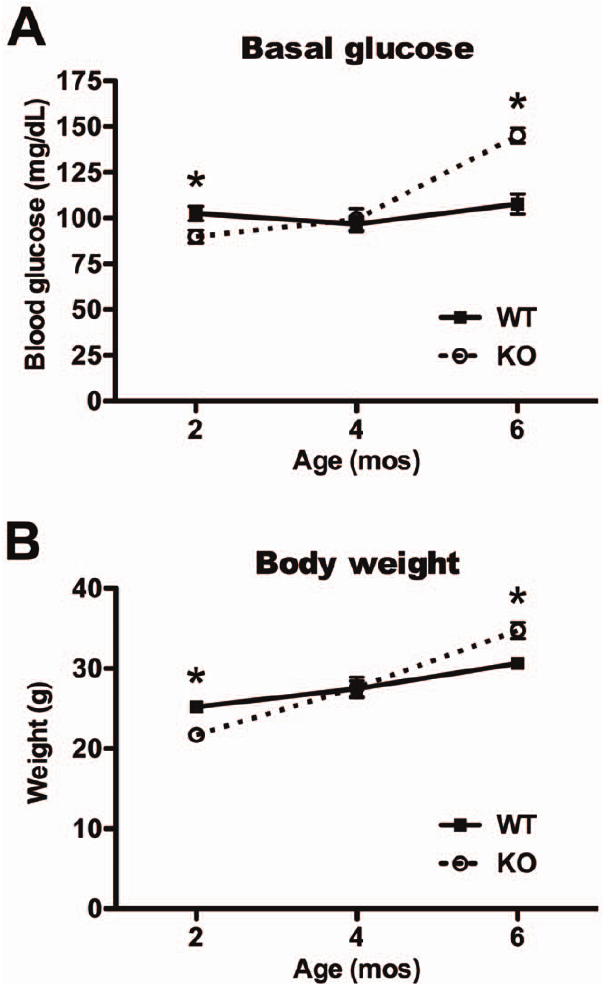
Figure 2. Age-dependent changes in basal blood glucose and body weight. A , Blood glucose in 2-, 4- and 6-mo-old wild-type (WT) and IDE-KO (KO) mice following overnight fasting. Note that 2-mo-old IDE-KO mice exhibit significantly lower basal glucose levels relative to controls. B , Body weight of fasted 2-, 4- and 6-mo-old WT and IDE-KO mice. Note that IDE-KO mice weigh significantly less than wild-type controls mice at 2 months yet significantly more at 6 months of age. Data are mean 6 SEM of 10–12 mice per group. *P , 0.05 IDE-KO vs. WT as determined by 2-tailed Student’s t test.